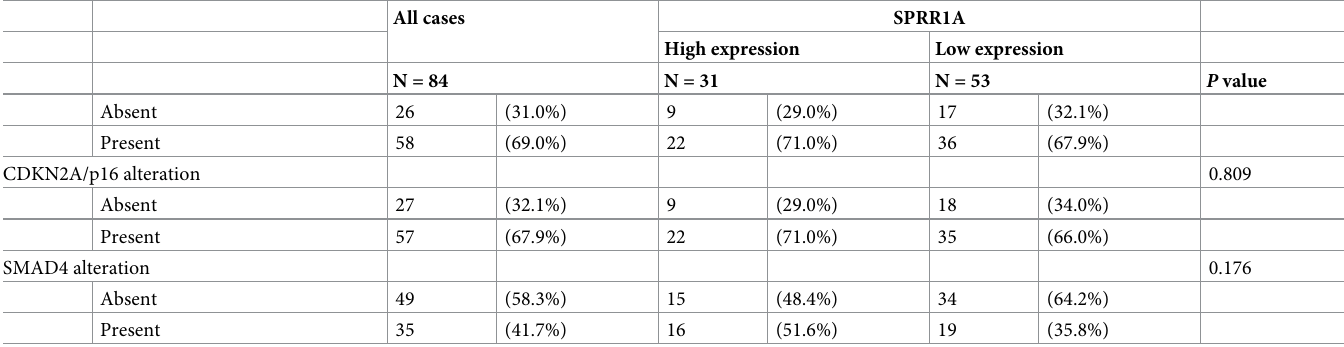
Next, we analyzed the relationship between the transcript level of SPRR1A and prognosis in PDAC using the TCGA-PAAD dataset to confirm our data. In TCGA analyses, we stratified 177 patients with pancreatic cancers by the transcript level of SPRR1A into three groups. The TCGA analysis clarified that the high and moderate SPRR1A groups had a significantly worse prognosis than the low SPRR1A group (median OS 50.1 months vs. 16.0 months vs. 17.7 months, p = 0.0020) (Figs 3A and S3A). Squamous differentiation, unlike the adenocarcinoma component, essentially expresses SPRR1A , as described above. After verifying that the expres- sion of keratin 5 (KRT5) did not correlate with that of SPRR1A (S3B Fig), we used the same method as in S1C and S1D Fig to exclude the eight patients with high transcript levels of KRT5 , a squamous epithelial marker [19], above the average plus two s.d. (S3C Fig). We ana- lyzed the TCGA-PAAD dataset again to assess the prognostic value of SPRR1A expression in non-squamous PDAC and obtained a similar result (median OS 35.3 months vs. 16.0 months vs. 18.2 months, p = 0.0086) (Fig